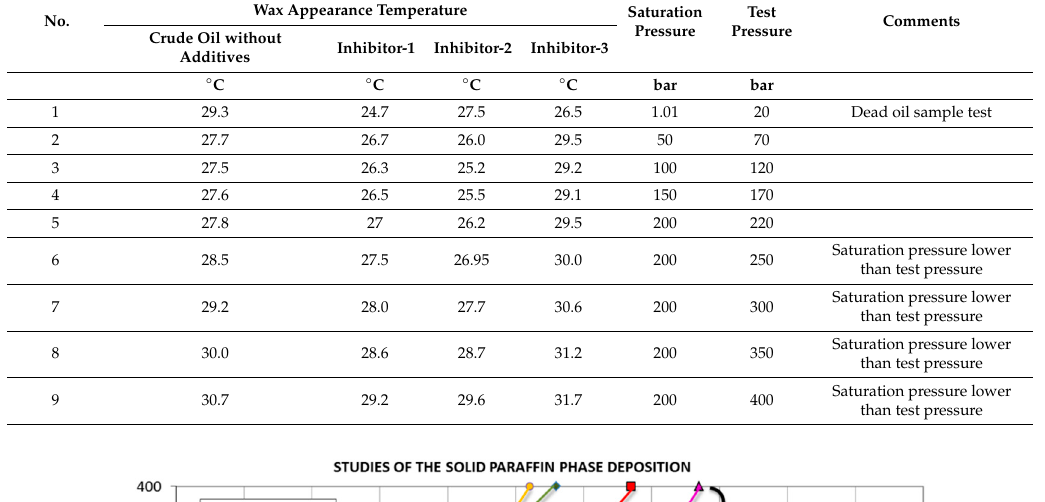
Table 7. Parameters of the pressure and temperature conditions of solid para ffi n phase deposition. Wax Appearance Temperature No.